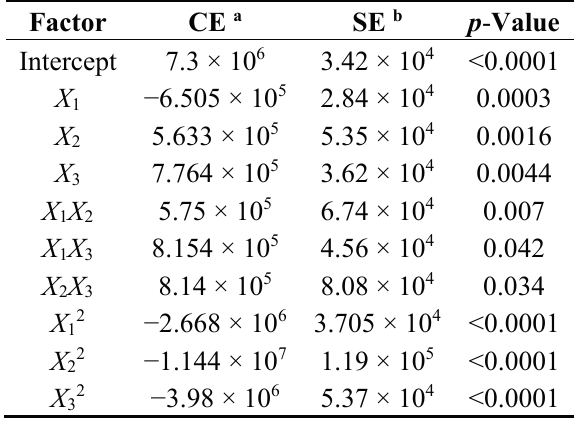
Table 4. Significance of the regression